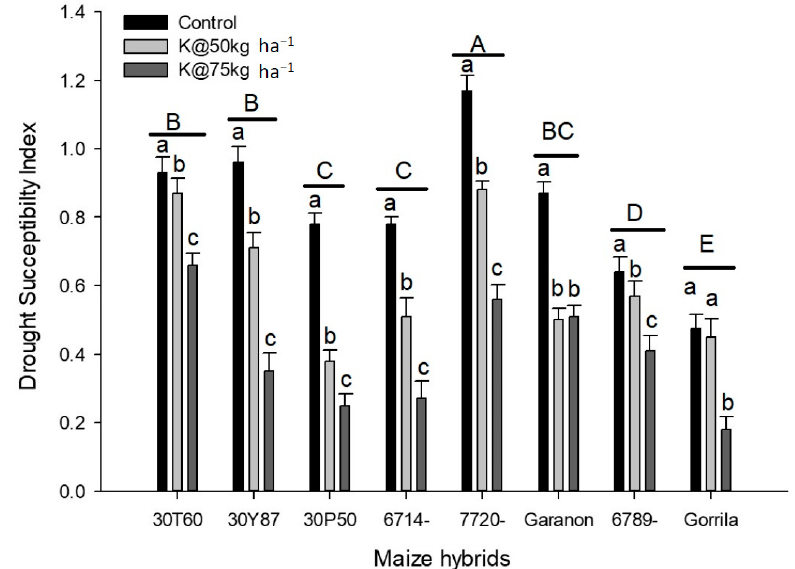
Figure 1. Drought susceptibility index of different maize hybrids under different treatments. Data are an average of two years and three replications. Small letters show the comparison between treatments of each hybrid and capital letters shows the comparison of different hybrids.